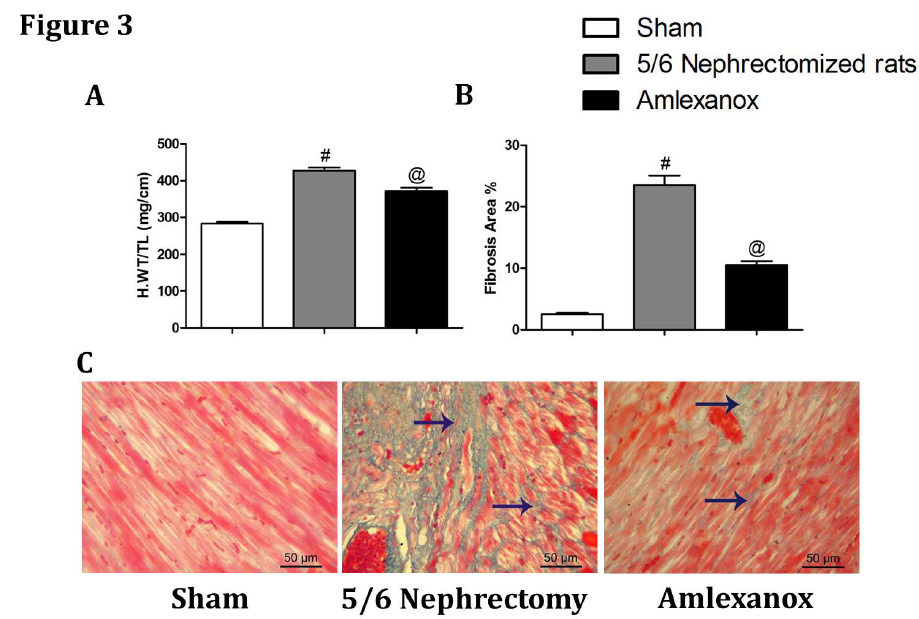
FIGURE 3 - Changes in heart weights and fibrosis area percentage. Graphical presentation of heart weight normalized to tibial length (H. WT/TL) (A) and fibrosis area % (B) . Representative photomicrographs of cardiac tissues stained with Mallory trichrome (C) . Amlexanox (25 mg/kg/day) was injected i.p. for 10 weeks, starting just after 5/6 nephrectomy. Groups